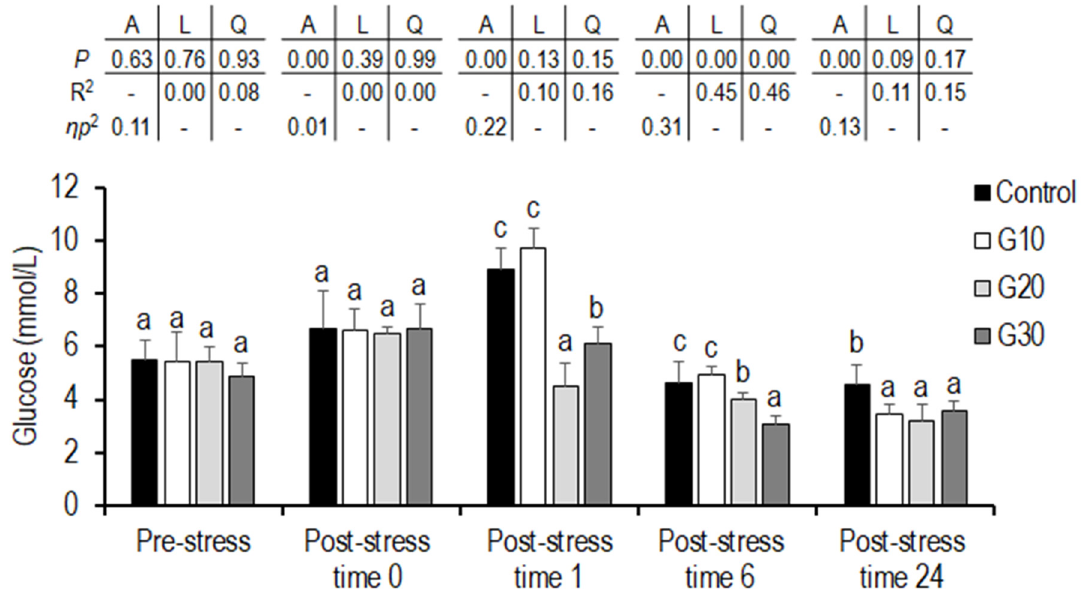
Figure 2. Serum glucose of Eurasian perch provided feed supplemented with garlic powder under high-density and net handling stress. Values are presented as (mean ± SD; n = 6). Mean values with different superscripts within each time vary significantly according to one-way ANOVA ( p < 0.05). A = the variance analysed by one-way ANOVA; L = the linear trend analysed by orthogonal polynomial contrasts; Q = the quadratic trend analysed by orthogonal polynomial contrasts; R 2 = R square. η p2 = partial eta squared. Control: without garlic supplement; G1: 10 g garlic powder per 1000 g diet; G2: 20 g garlic powder per 1000 g diet; G3: 30 g garlic powder per 1000 g diet. Pre-stress: before stress; Post-stress time 0: immediately after stress; Post-stress time 1: one hour after stress; Post-stress time 6: 6 h after stress; Post-stress time 24: 24 h after